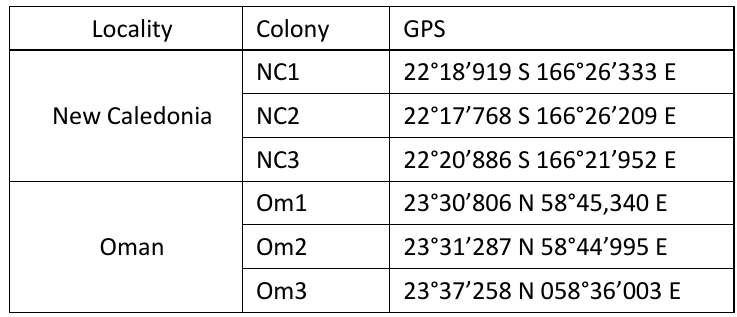
Table 1. Sampling sites